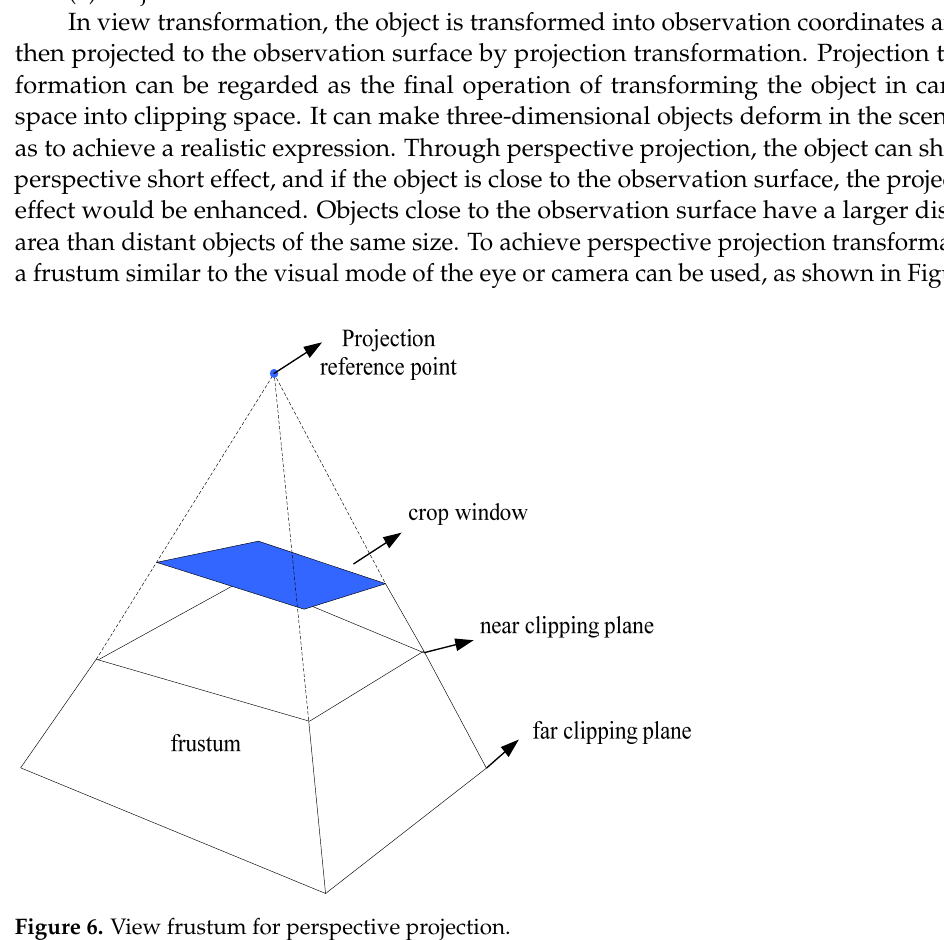
Figure 6. View frustum for perspective projection. In the viewing direction, the distance between the far side of the frustum and the projection point is greater than the near side, while the bottom, top and sides are the planes that intersect the projection fiducial point. On the viewing plane, only objects lo- cated in the frustum are included, and all objects outside the frustum are cut. At this time, a stereo projection transformation matrix can be used to complete the projection transfor- mation. (4) The basic principle of stereo vision Stereoscopic view is the core of AI system interactive vision, and users can feel the real virtual world in three-dimensional space. Stereoscopic images are paired. In the same scene, from different perspectives, it is consistent with the point of view when people look at the object. Stereoscopic vision is an important visual function of human beings, which can make people produce an intuitive and profound perception, and this feeling can be stimulated by the stereoscopic vision produced by different angles of one eye. In general, humans and animals with overlapping light fields have this ability. A fainter beam of light would enter the human eye and end there. At this point, people must engage with types kinds of information. One is from the location of the light source, and the other is when the light passes through the retina of the eye. Regarding the processing of the visual cortex and the brain, it is necessary to know the source of light. To solve this problem, the light from both eyes must be directed. Assuming that, at this point, the light enters the eye in a